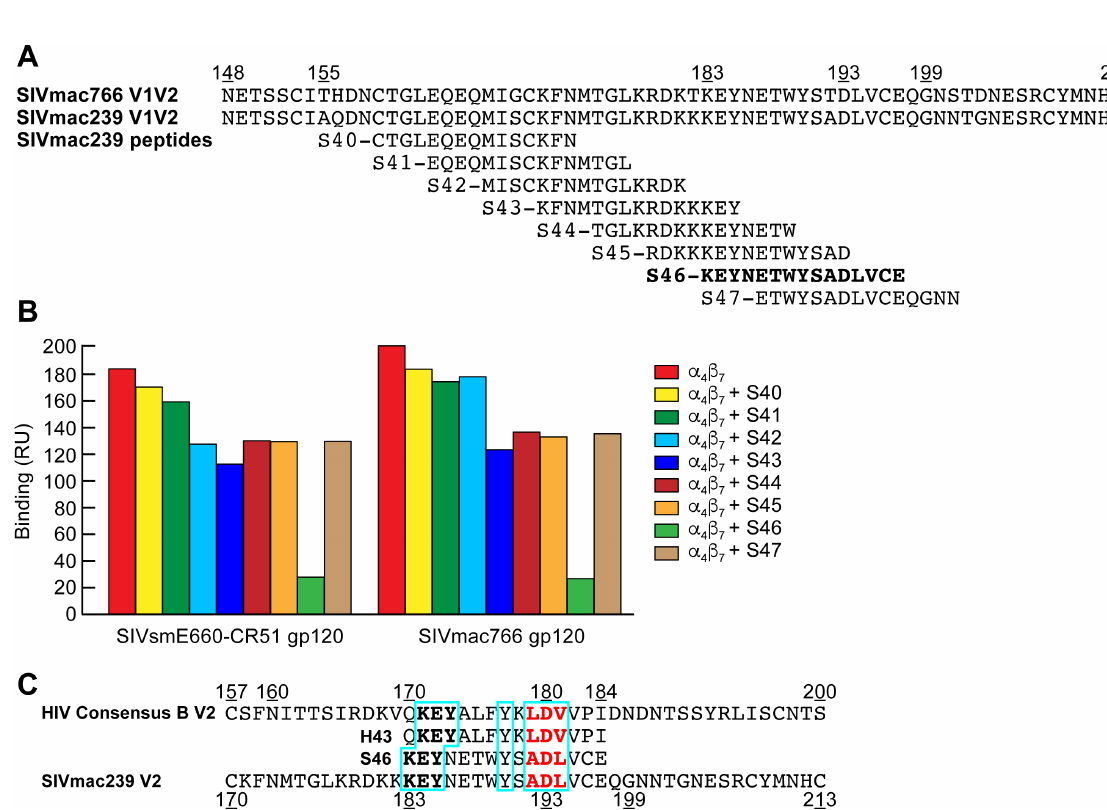
Fig 7. Inhibition of α 4 β 7 binding to SIV gp120 by V2 peptides. A) Alignment of the V1V2 domains of SIVmac766 and SIVmac239, and eight overlapping 15 mer peptides of SIVmac239 (S40-S47). B) Inhibition of soluble α 4 β 7 binding to SIVsmE660-CR51 and SIVmac766 gp120s by overlapping SIV 15mer peptide. Binding was determined by SPR analysis and binding RU at 200 seconds following the addition of α 4 β 7 is listed (y-axis). Results are representative of three or more independent experiments C) Alignment of the V2 domains of HIV consensus B and SIVmac239, and peptides H43 and S46. The tri-peptide motifs (aliphatic-Asp-aliphatic residue) are highlighted in red and regions of sequence identity are boxed in